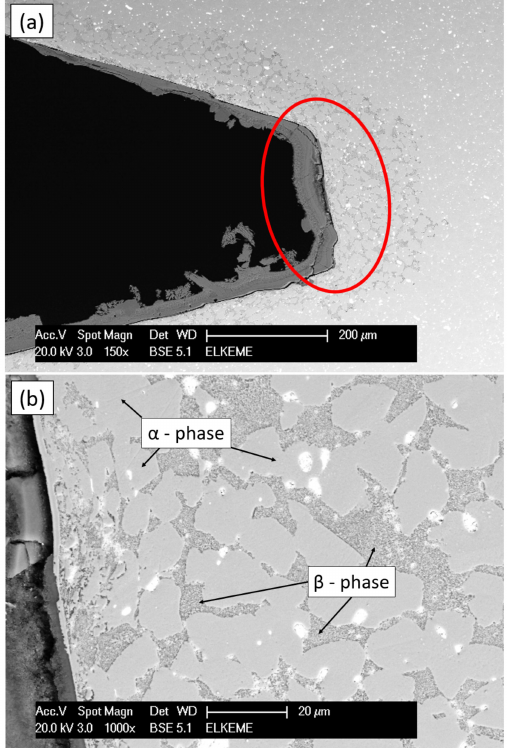
Figure 4. ( a ) BSE SEM Micrograph showing the dezincification area of a brass component. ( b ) Detail of ( a )